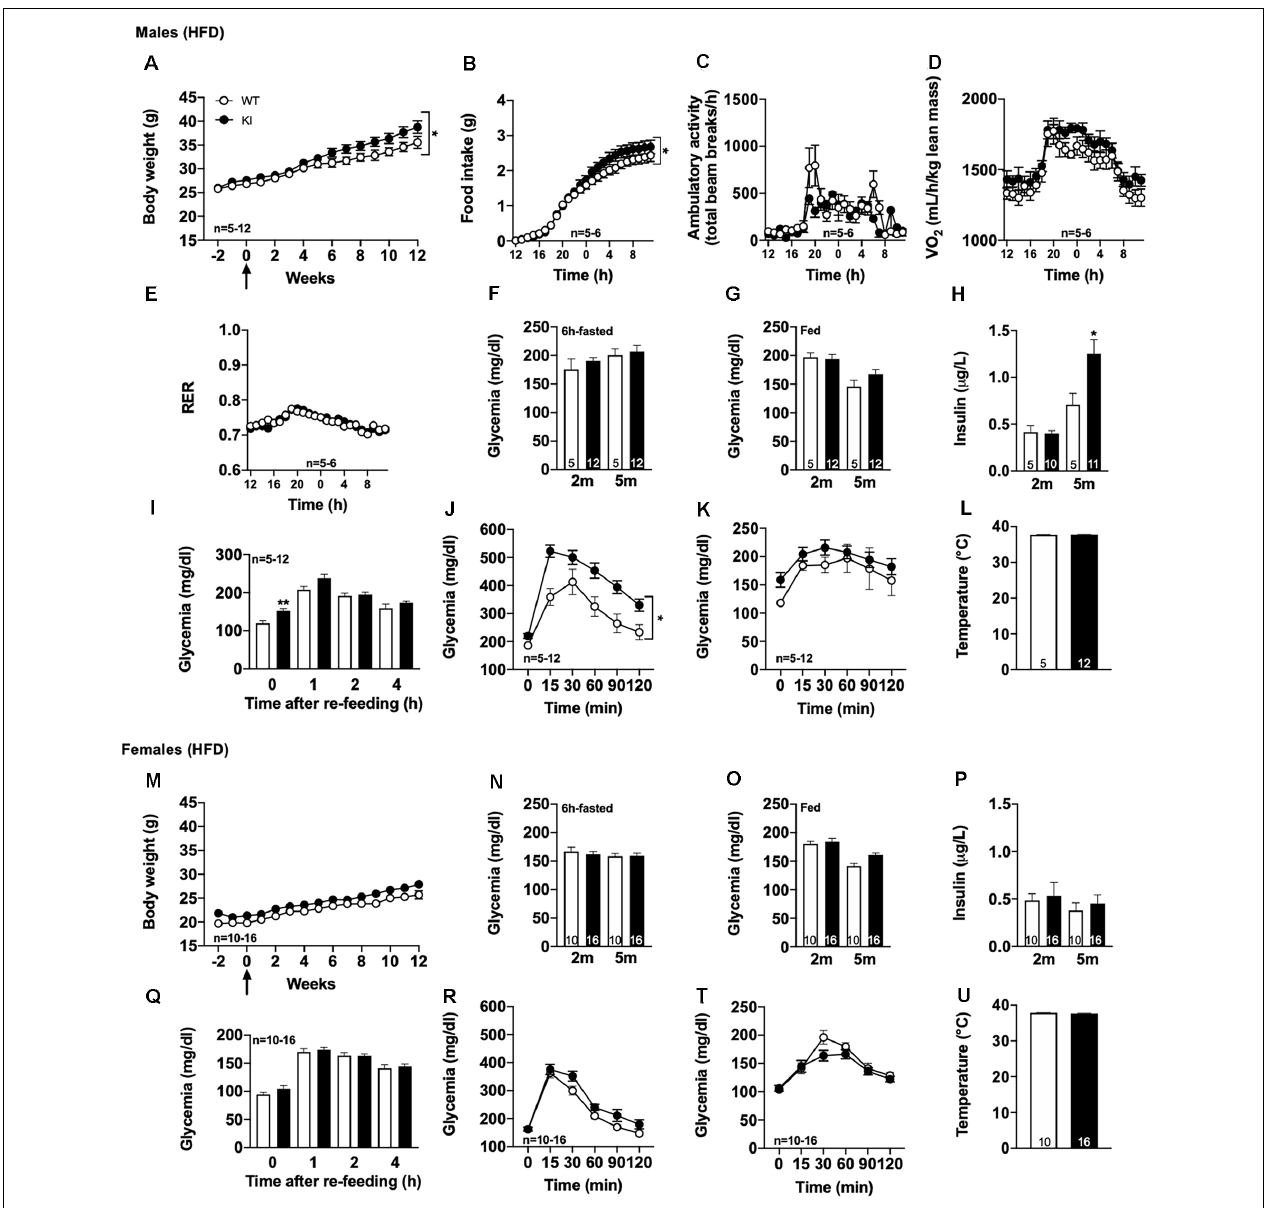
FIGURE 2 | Metabolic phenotyping of tau KI mice under High Fat diet (HFD; given from 2 to 5 months of age). (A–L) : Males. (A) Body weight gain of WT and tau KI mice under HFD from 2 to 5 months of age (Two-Way ANOVA; F (14,210) = 1.807, * p < 0.05 vs. WT). (B–F) Metabolic cage evaluation of tau KI male mice: (B) 24 h-cumulative food intake (g) (Two-Way ANOVA; F (23,207) = 2.401, * p < 0.05 vs. WT). (C) 24 h spontaneous locomotor activity (total beam breaks/h). (D) 24 h-respiratory exchange ratio (RER = VCO 2 /VO 2 ). (E) 24 h-O 2 consumption. (F) Glycemia after 6 h of fasting before (2 m) and at the completion of HFD (5 m; NS, One-Way ANOVA). (G) Glycemia in fed condition (9 a.m) before (2 m) and at the completion of HFD (5 m; NS, One-Way ANOVA). (H) Insulinemia after 6 h of fasting before (2 m) and at the completion of HFD (5 m; One-Way ANOVA followed by Tukey’s post-hoc test; F (3,27) = 13.34 p < 0.0001; * p < 0.05 vs. WT). (I) Glycemic variations during the 1st, 2nd and 4th h following re-feeding after 16 h of fasting at the completion of the HFD, i.e., 5 months of age (One-Way ANOVA followed by Tukey’s post-hoc test; F (7,60) = 19.83 p < 0.0001; * p < 0.05 vs. WT * p < 0.05 vs. WT for glycemia after 16 h). (J) Intraperitoneal glucose tolerance test (IPGTT) at completion of the HFD, i.e., 5 months of age (* p < 0.05, Two-Way ANOVA). (K) Pyruvate tolerance test (PTT) at completion of the HFD, i.e., 5 months of age (NS, Two-Way ANOVA). (L) Rectal temperature at the completion of the HFD, i.e., 5 months of age (NS, Student’s t-test). (M–U) : Females. (M) Body weight gain of WT and tau KI mice under HFD from 2 to 5 months of age (NS). (N) Glycemia after 6 h of fasting before (2 m) and at the completion of HFD (5 m; NS). (O) Glycemia in fed condition 9 a.m. before (2 m) and at the completion of HFD (5 m; NS). (P) Insulinemia after 6 h of fasting before (2 m) and at the completion of HFD (5 m; NS). (Q) Glycemic variations during the 1st, 2nd and 4th h following re-feeding after 16 h of fasting at the completion of the HFD, i.e., 5 months of age (NS). (R) Intraperitoneal glucose tolerance test (IPGTT) at the completion of the HFD, i.e., 5 months of age (NS). (T) Pyruvate tolerance test (PTT) at the completion of the HFD, i.e., 5 months of age (NS). (U) Rectal temperature at the completion of the HFD, i.e., 5 months of age (NS). Results are expressed as mean ± SEM. WT mice are indicated as white circles/bars, tau KI mice as black